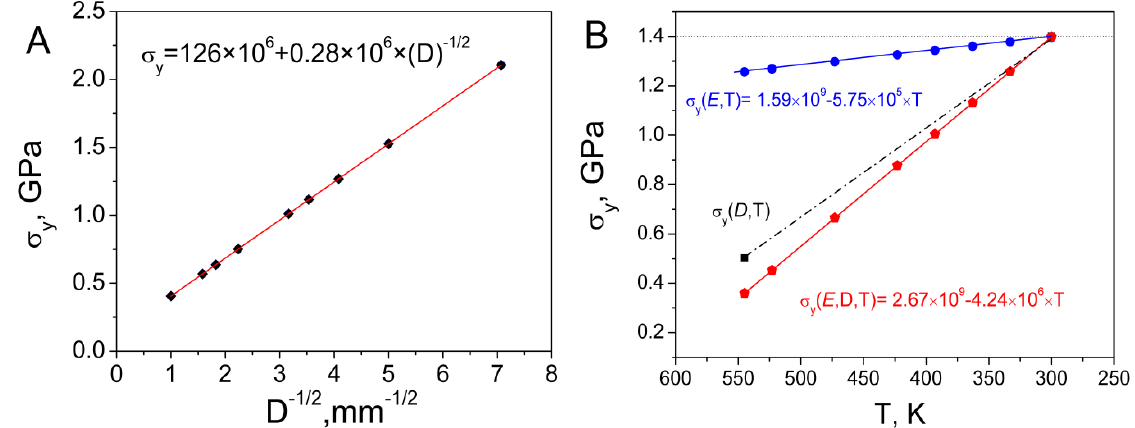
Figure 6. ( A ) Dependence of the Yield stress on grain size in Mg films. ( B ) Effect of the Young modulus, σ (E,T) (blue line), grain size σ (D,T) (black dotted line) and their y y combined influence, σ (E,D,T) (red line) on the Yield stress in Mg films. Solid lines are y linear fits with the corresponding temperature dependences and the dotted line is just a guide for the eye. Dashed line at 1.4 GPa represents the Yield stress of Mg film with no temperature